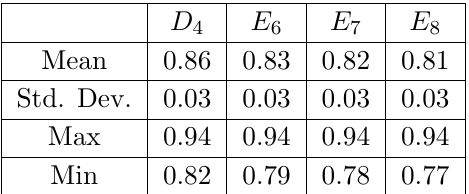
Table 3. Table of means and standard deviations for the ratio a IR =c IR across the entire nilpotent network de(cid:12)ned by plain mass deformations of probe D3-brane theories. We also display the maximum and minimum